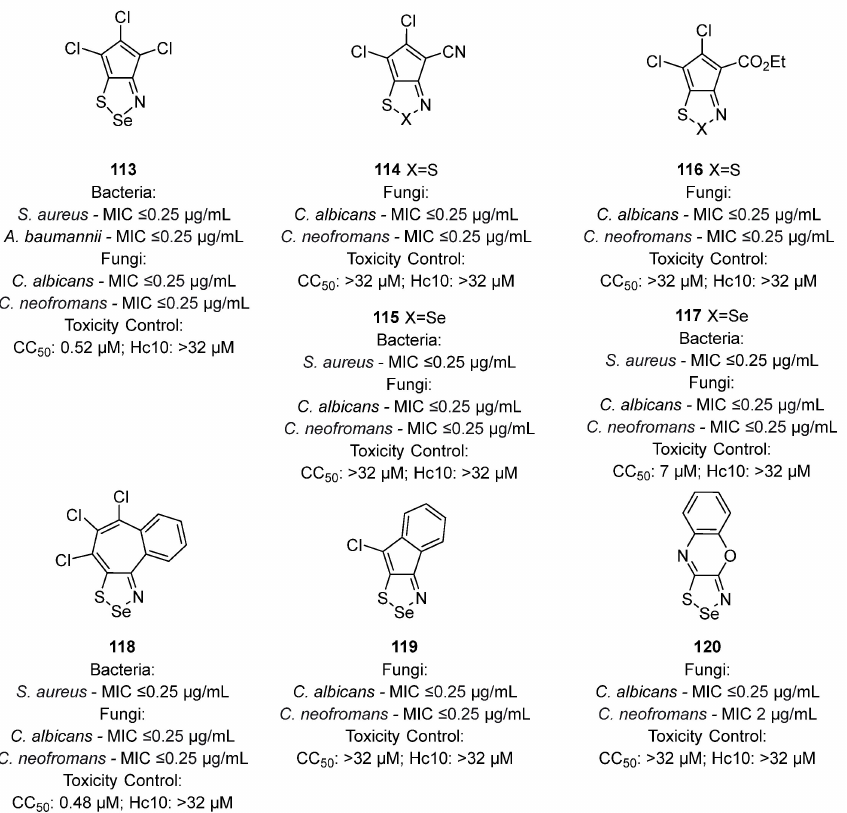
Figure 20. Summary of the most active antifungal 1,2,3-dithiazoles and 1,2,3-thiaselenazoles from the 2020 study by our group